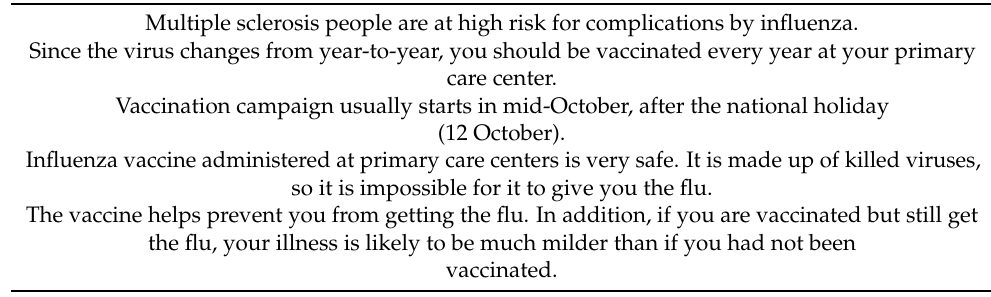
Table 1. Information and medical advice provided about flu vaccination. Multiple sclerosis people are at high risk for complications by